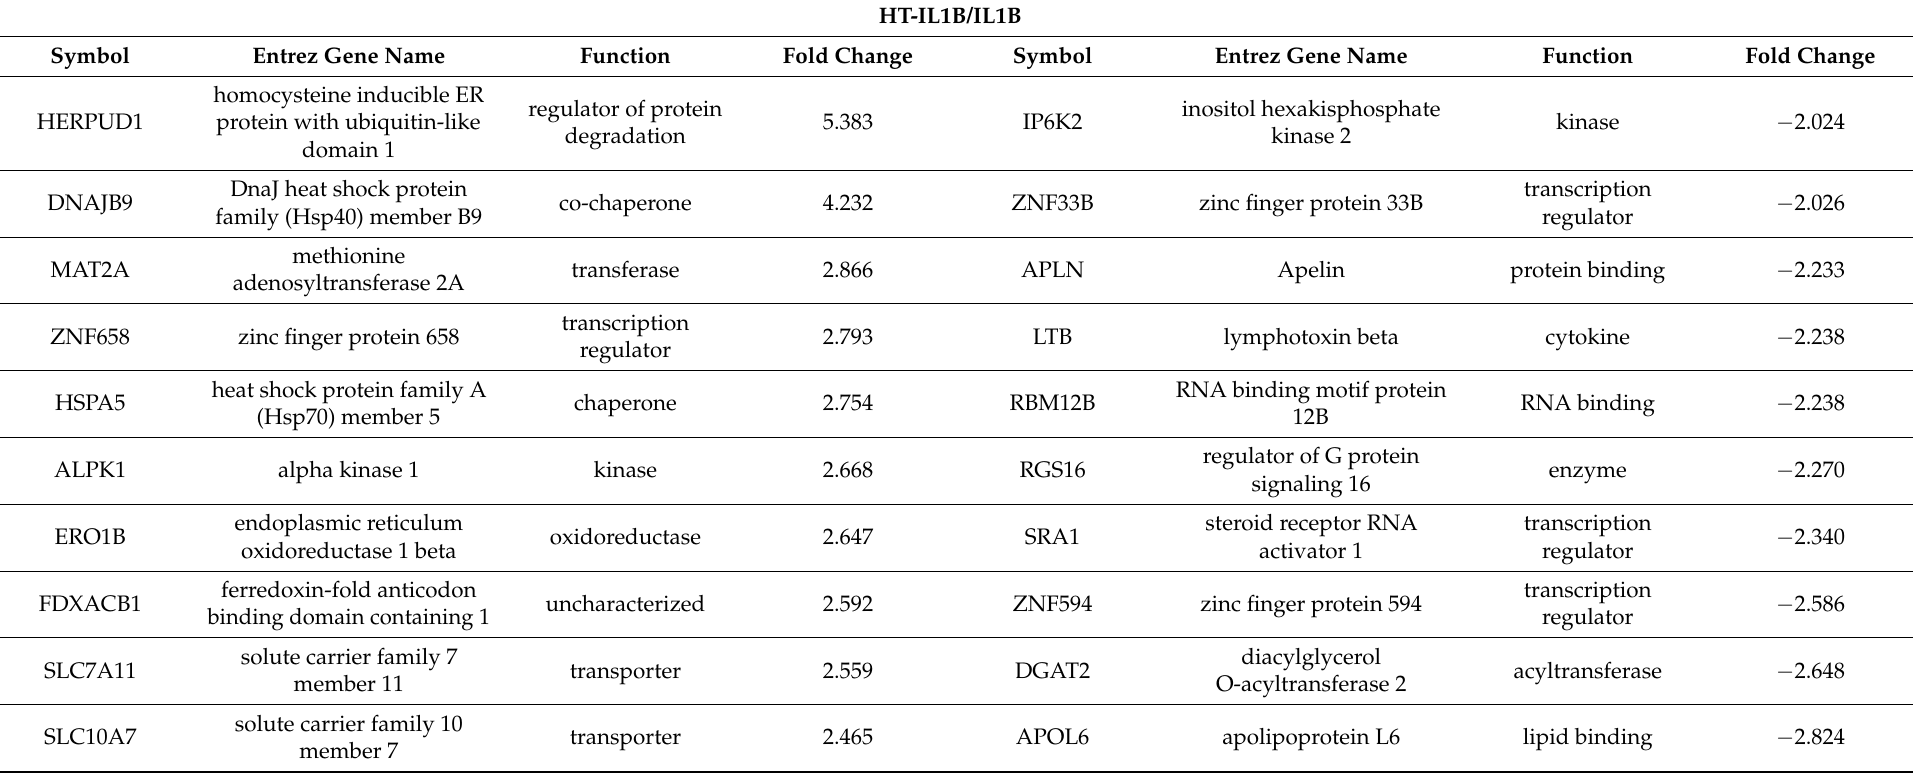
Table 4. The top 10 up-regulated or down-regulated genes by HT in endothelial cells at stimulated conditions (HT-IL1B/IL1B).